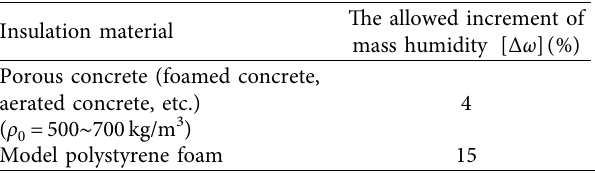
Table 3: The allowed increment of mass humidity of the envelope insulation material during heating period.